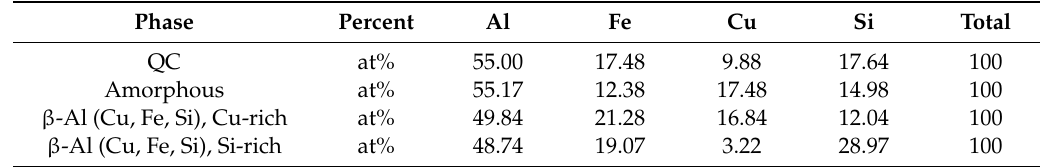
Figure 7. SAED pattern of QC in the coating obtained along the twofold, threefold, and fivefold axes; diffraction pattern of the amorphous phase. Table 3. EDS results of different phases in the coating.